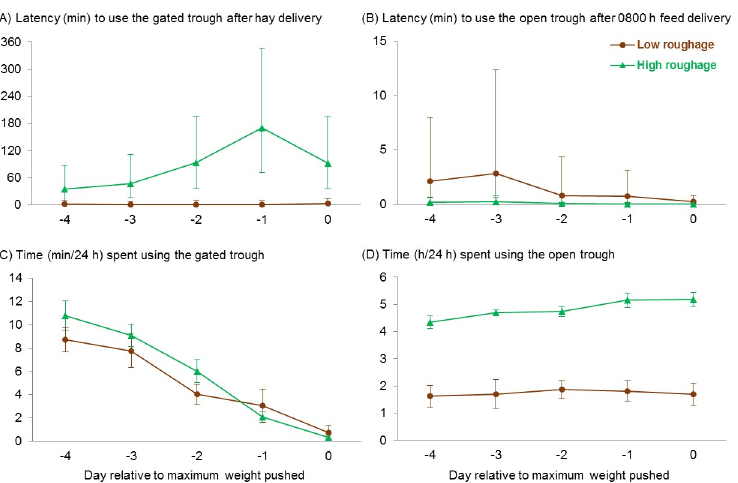
Fig 3. Latency and time spent using each trough. Back-transformed means and 95% confidence intervals are shown for the latency to use the (A) gated and (B) open trough after the 0800 h feed delivery and means ± SEM for the total time heifers spent using the (C) gated and (D) open trough. All heifers were fed 200 g/d of Sudan grass hay behind a gate that must be pushed to gain access, and to which additional weight was added daily until cattle no longer used it. In the unrestricted open trough, heifers had free access to either a total mixed ration with 12% forage (as fed, low roughage, n = 6) or 100% Sudan grass hay (high roughage, n = 6). To allow for consistent comparisons among heifers, behavior was evaluated on 5 d (relative to the day they pushed the maximum weight), and data are presented across days. Day was included in the model as a continuous variable, but was summarized as categorical for graphing